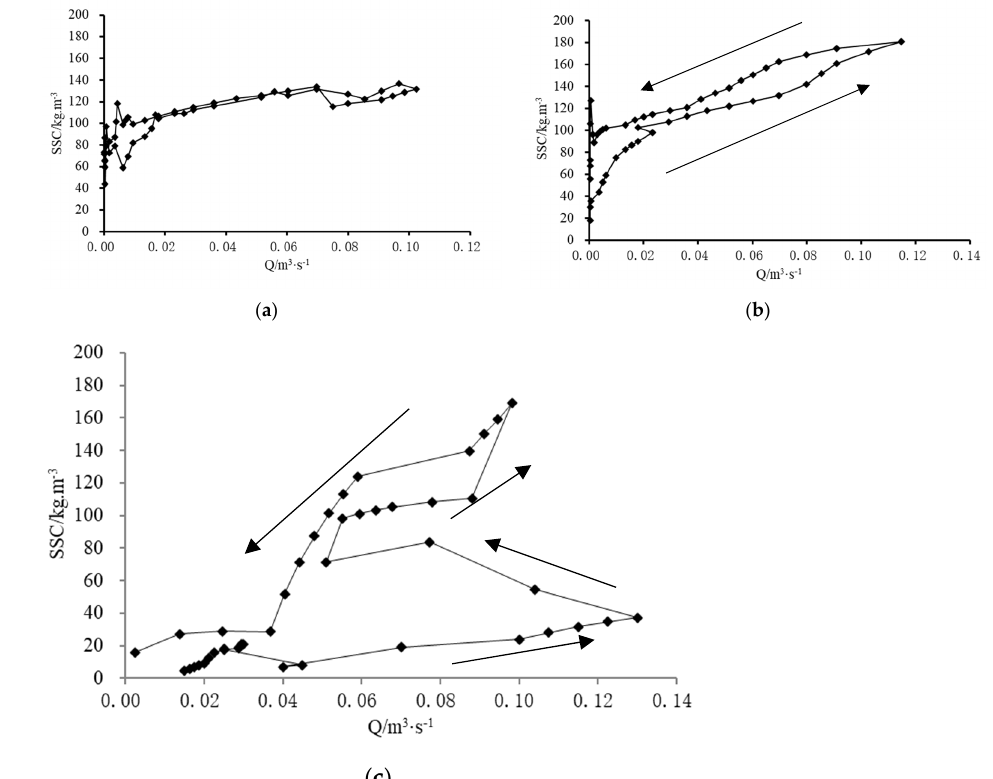
Figure 6. Relationships between SSC and Q of the different geomorphic units on 18 September 2008. ( a ) Whole slope; ( b ) first branch of Qiaogou (subgully); ( c ) Qiaogou gully.